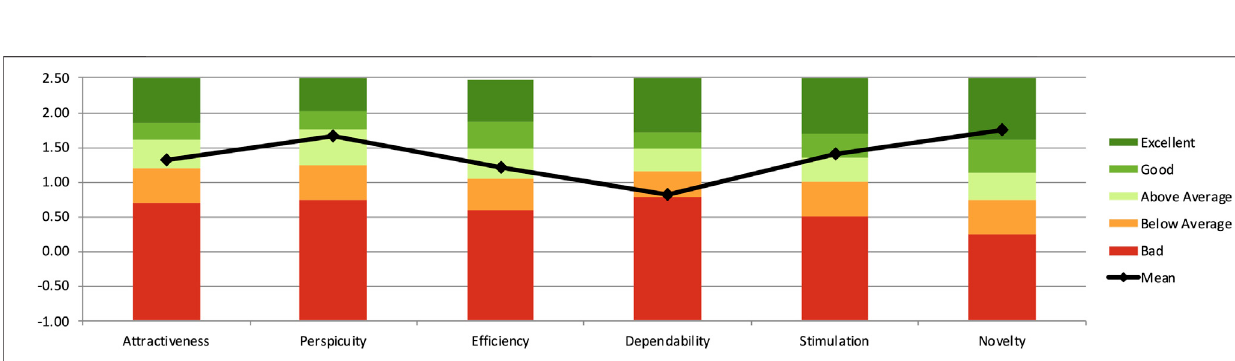
Frontiers in Virtual Reality |